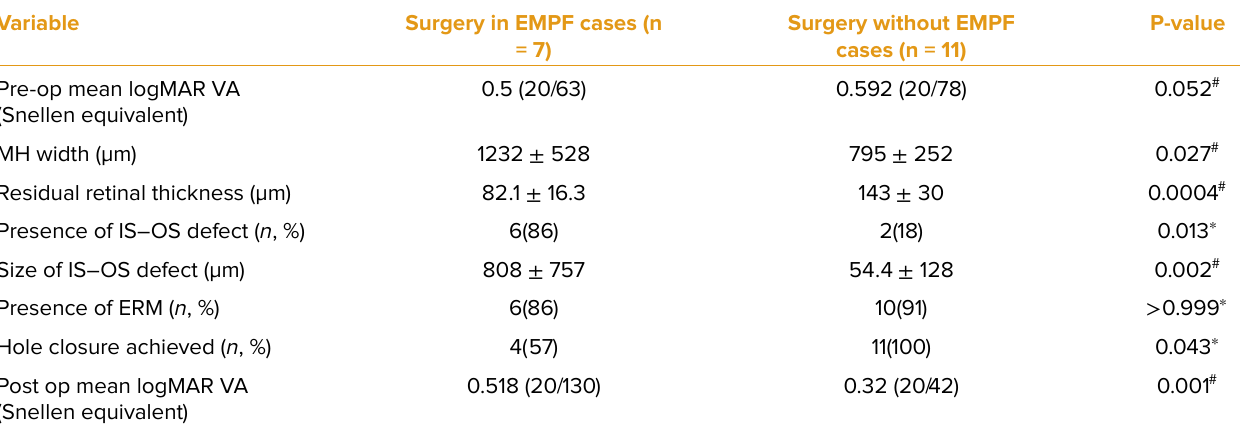
Post op mean logMAR VA 0.518 (20/130)